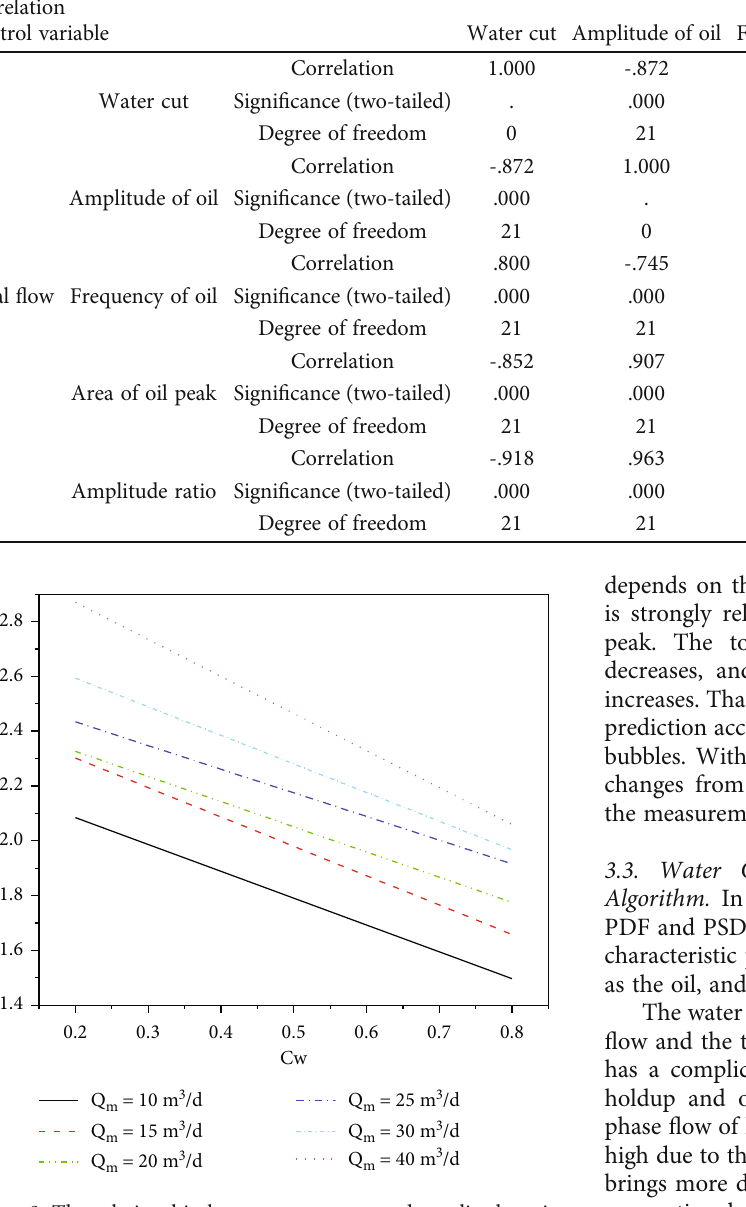
Table 5: Analysis table of partial correlation of variables related to oil-water two-phase fl ow.